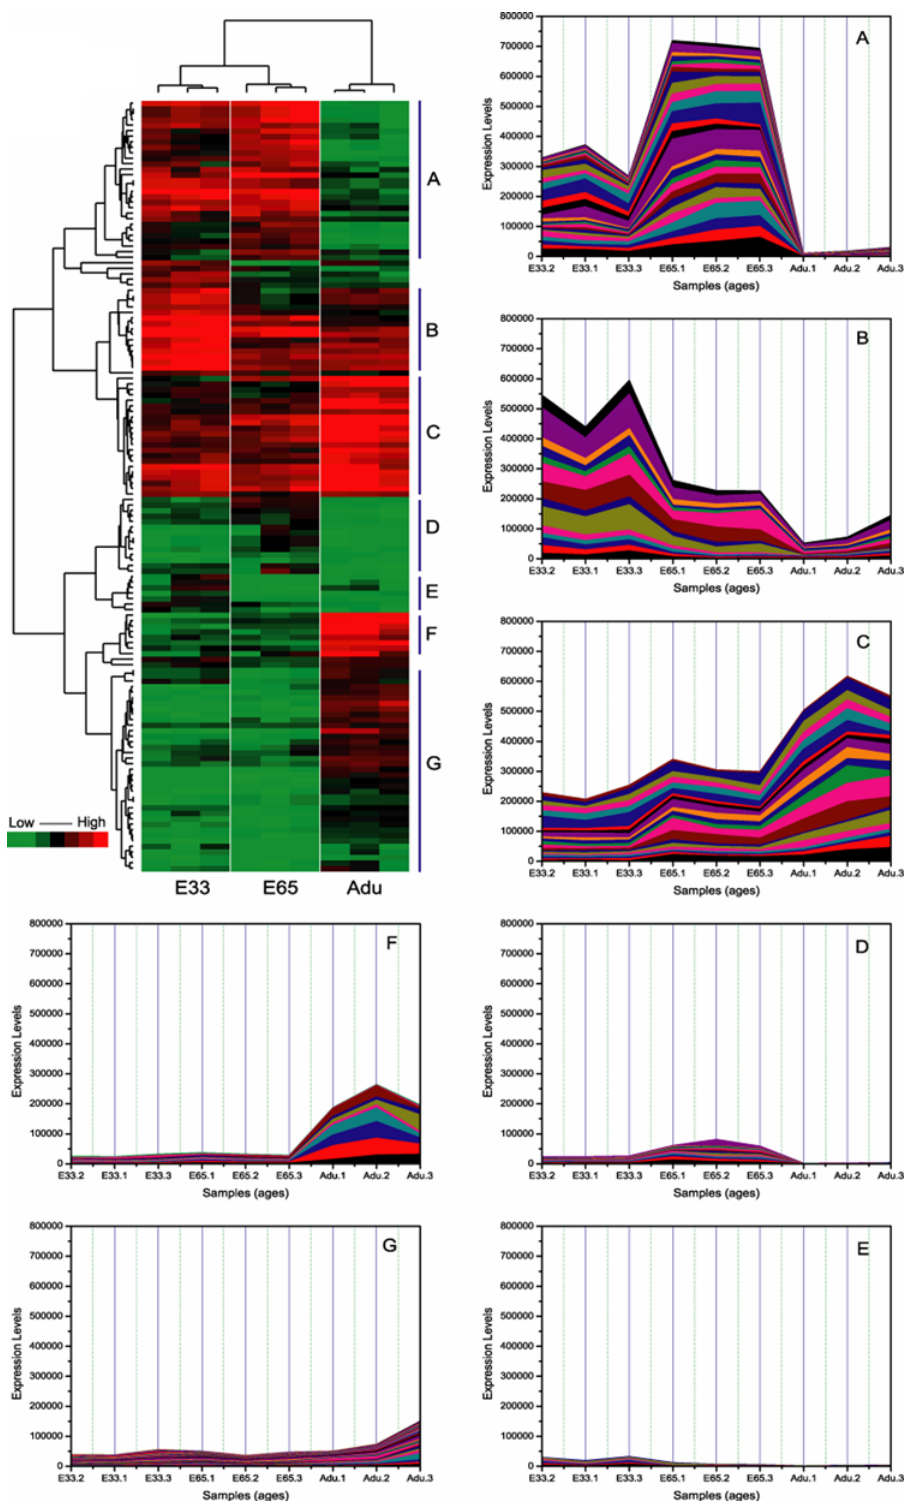
Figure 3. Hierarchical cluster analysis. We performed a data adjustment (median center and normalization) in the cluster analysis. The color codes of red, white, black and dark green represents expression levels of high, average, low and absent respectively. A detailed view of the miRNA expression levels in clustering patterns is shown in the plot areas from A to G.